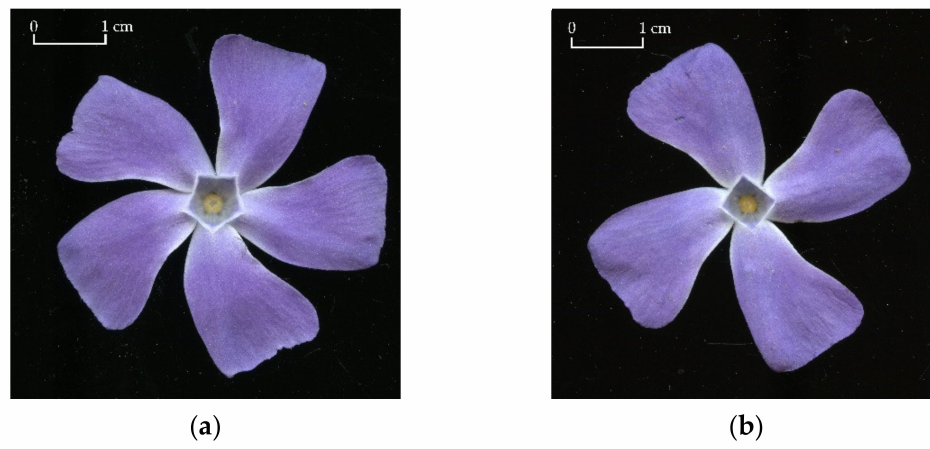
Figure 1. Representative flowers of Vinca major L. with five ( a ) and with four petals ( b ). Pentagonal symmetry is a general condition in Eudicots [16], but a clear pentagonal shape, as in the corolla tube of Vinca , is uncommon. In trumpet, campanulate or salverform corolla tubes, the transition from fused proximal parts of the petals to the free parts is gradually curved. In Vinca , on the other hand, the plane formed by the free ends of the petals is almost perpendicular to the corolla tube. Although the ORCT is never completely flat, a projection using a photography or an image scanner can be obtained, making a